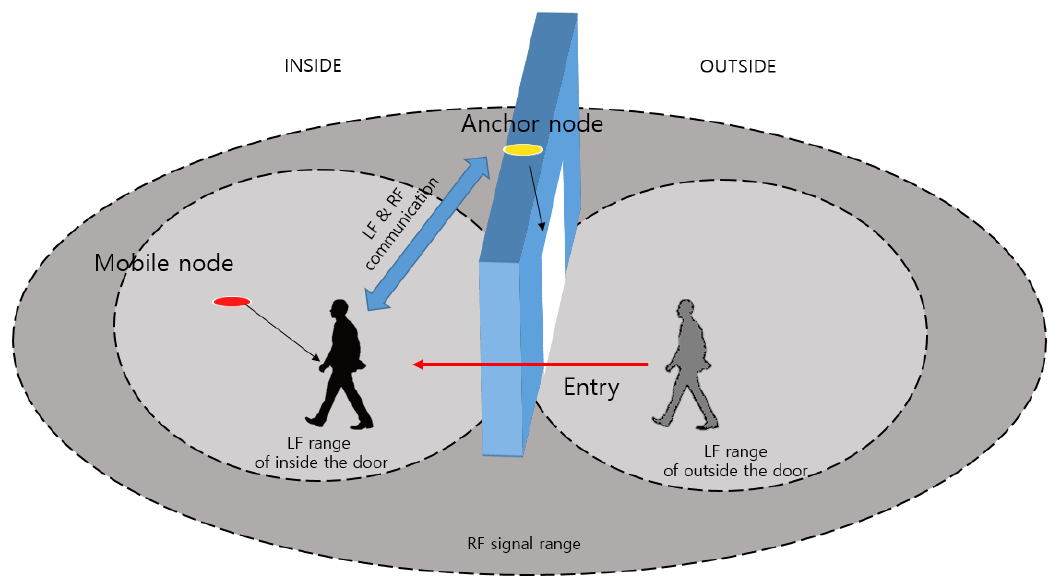
Figure 1. Situation Aware Service Scenario.